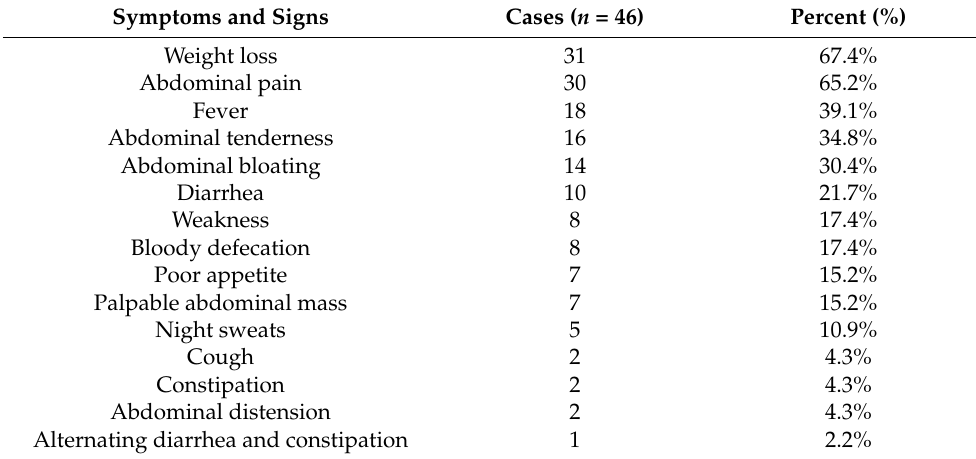
Table 3. Clinical manifestations of patients with intestinal